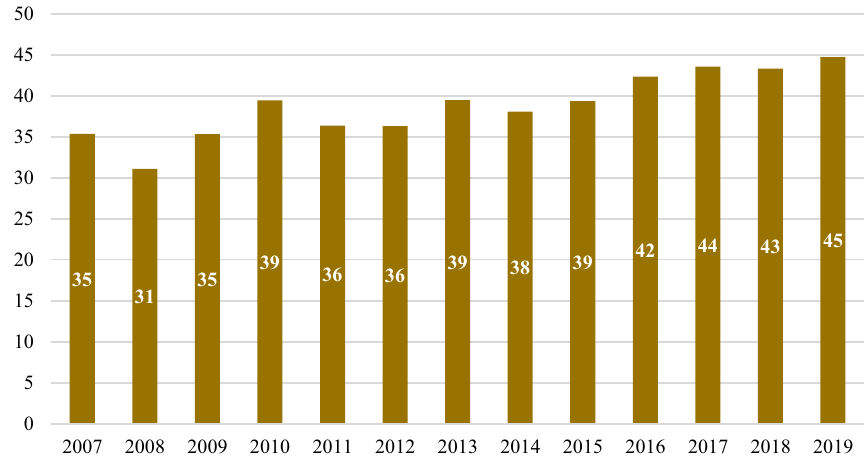
Fig. 4 Indicators M2/GDP of the Russian economy in 2007–2019. Sources : Goskomstat (2022), Bank of Russia (2020), author’s